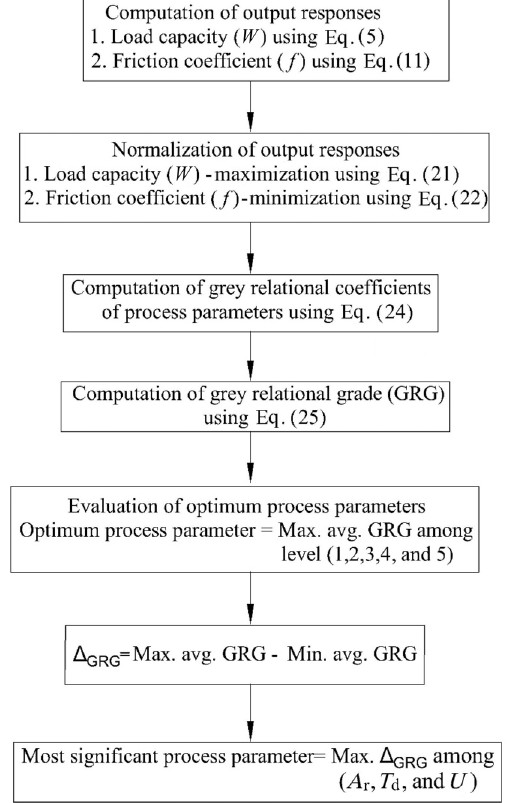
Fig. 6 Flow chart of GRA for multi-objective